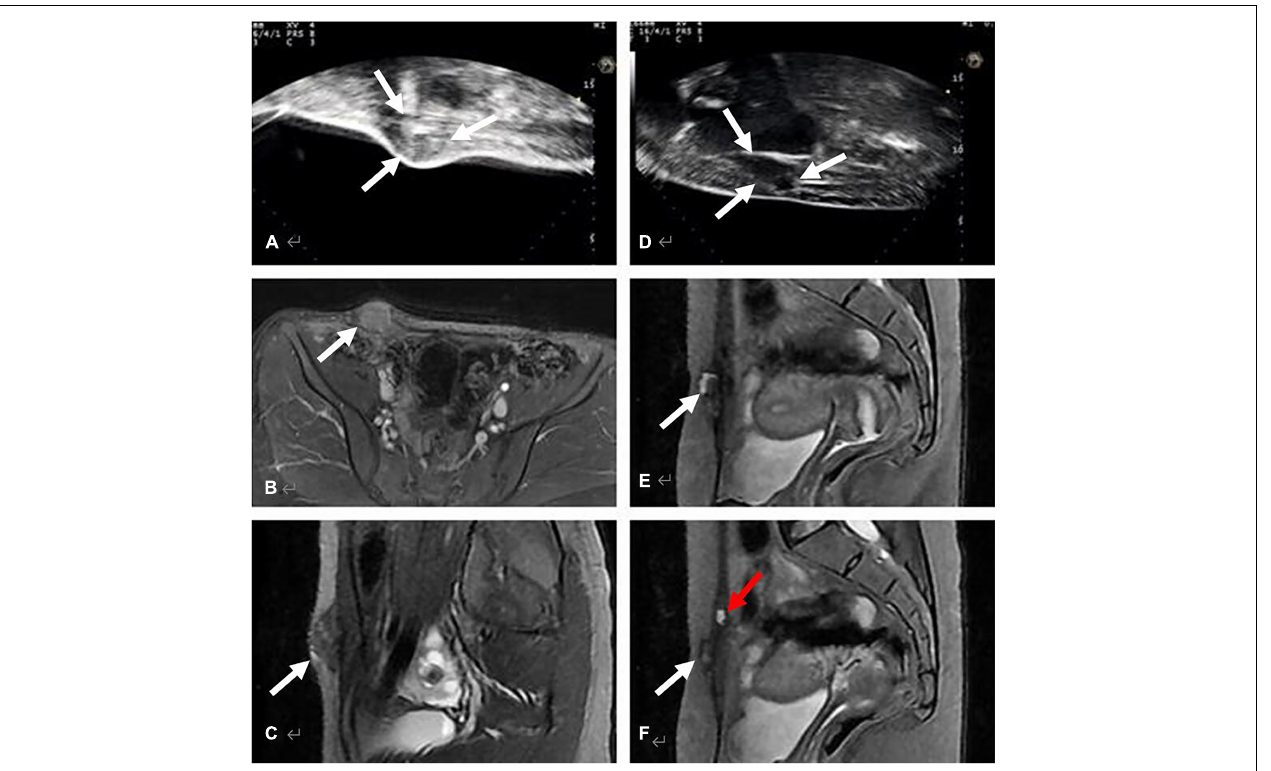
FIGURE 2 | Comparison of AWE lesions between MRI and color Doppler ultrasound before HIFU treatment. (A–C) show an AWE lesion on the right horn of the scar, located in subcutaneous fat, invaded the skin and the anterior sheath of the right rectus abdominis: (A) Long-axis sonogram showed a hypoechoic, nodular mass (white arrow). (B,C) show the axial and sagittal T2-weighted MRI of the same lesion, MRI images were clearer than ultrasound images in terms of size and boundary of the AWE lesion. (D–F) show AWE in a 27-year-old woman with complaints of cyclical pain symptoms after cesarean section, due to the presence of 5 cm of abdominal wall fat. Ultrasound images (D) revealed only one lesion, while MRI clearly revealed two lesions, along with the location and shape of AWE (E,F) .